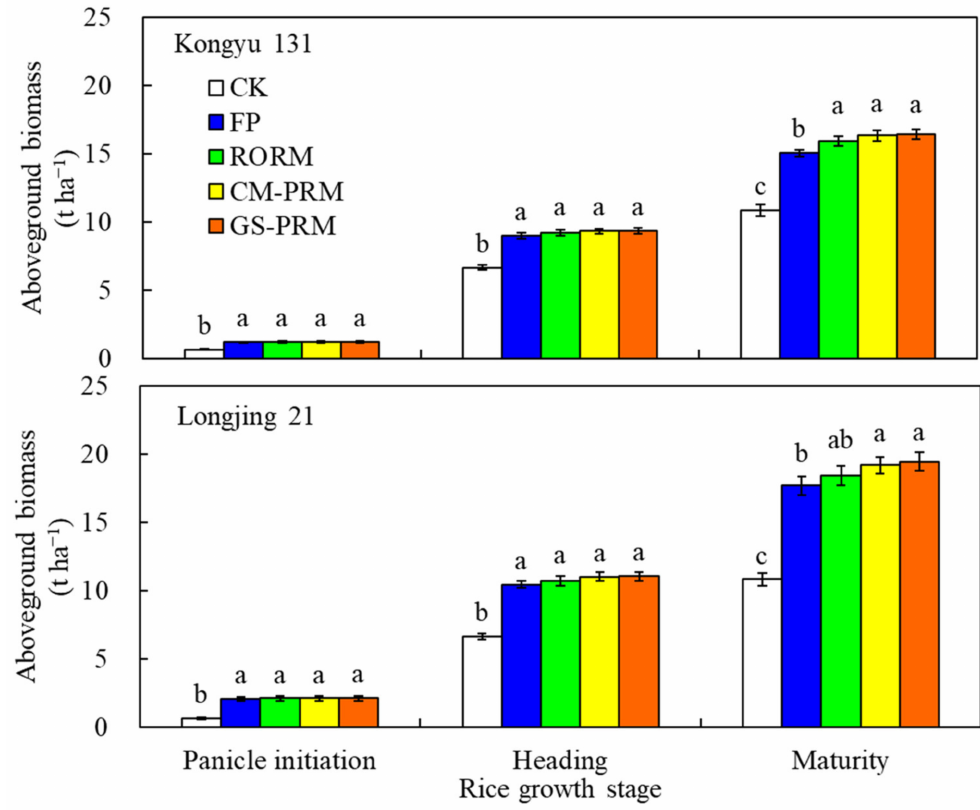
Figure 3. The three-year (2011–2013) average of aboveground biomass of two rice varieties, Kongyu 131 ( top ) and Longjing 21 ( bottom ), at different growth stages produced in different rice man- agement systems. CK, FP, RORM, CM_PRM, and GS_PRM represent check treatment, farmer’s practice, regional optimum rice management, chlorophyll meter-based precision rice management, and GreenSeeker sensor-based precision rice management, respectively. Different letters indicate significant differences at p < 0.05 level at the same growth stage. The error bars indicate the standard